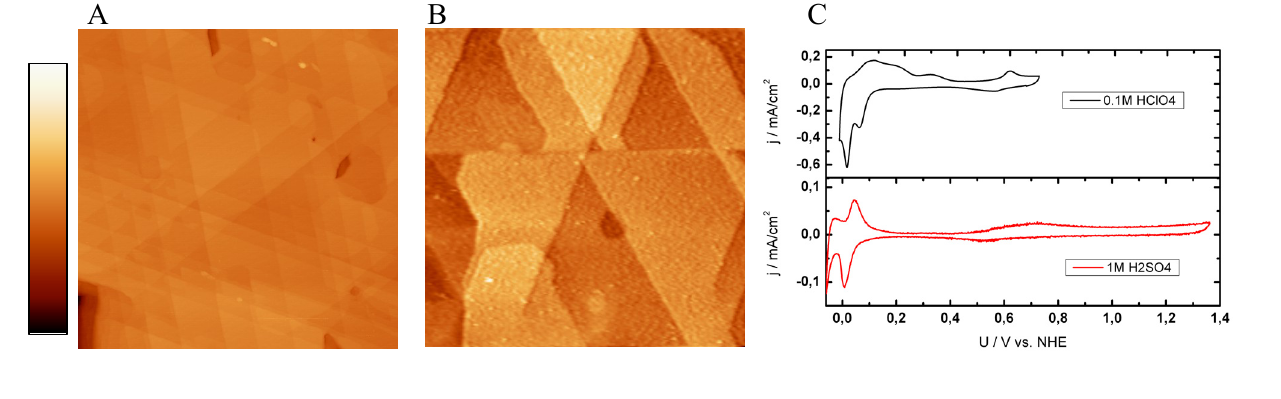
Figure 3. EC-STM, SECPM and CV of Rh(111): (A) In situ EC-STM (500 nm × 500 nm, = 10 nm) U = 500mV vs. NHE, (B) SECPM (200 nm × 200 nm, h h max S image of Rh(111) in 0.1 M HClO at U = 500 mV vs. NHE (C) CVs obtained in 0.1 M 4 S (black curve) and 1 M H SO (red curve) with a scan rate of 100 mVs -1 . Imaging HClO 4 2 4 conditions: STM: I = 1 nA, U = 100 mV, SECPM: ∆ U = 5 T bias